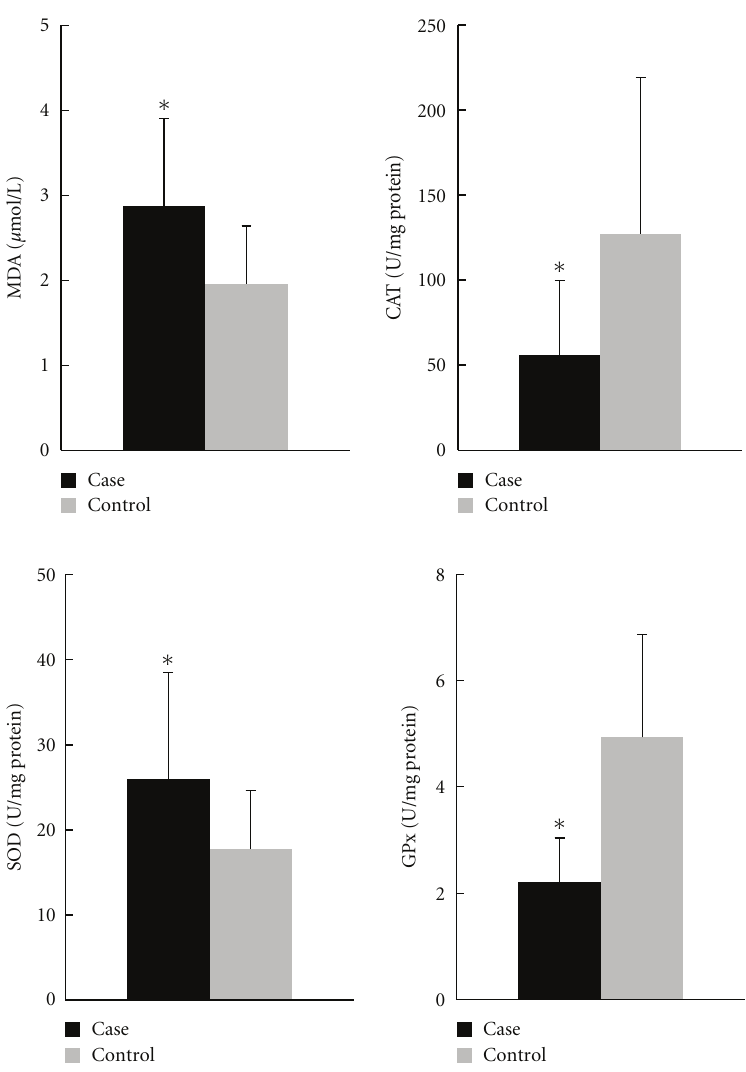
Figure 2: Concentration of lipid peroxidation and antioxidant enzymes activities. ∗ Values were significantly di ff erent between case and control groups; P < 0 . 01. CAT: catalase; GPx: glutathione peroxidase; MDA: malondialdehyde; SOD: superoxide